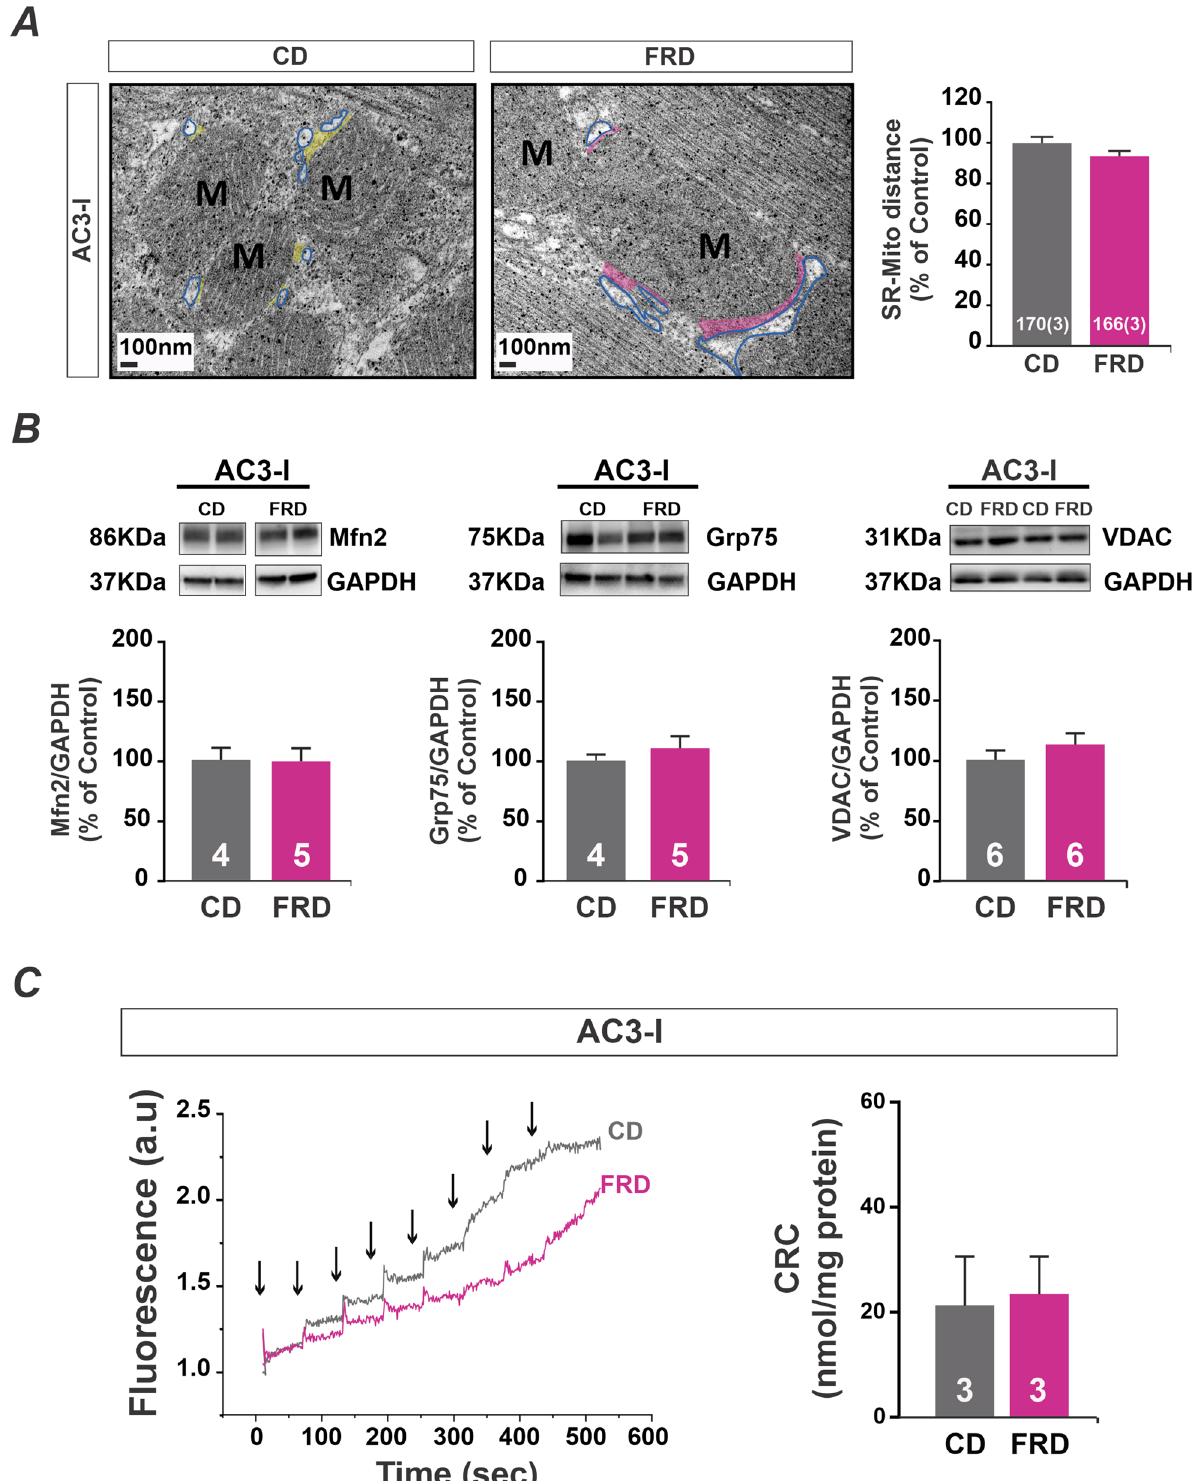
Figure 6. Genetic CaMKII inhibition prevents SR-mitochondria increased proximity avoiding mitochondrial Ca 2+ retention capacity in prediabetic mice heart. ( A ) Left, representative skeletonized photographs of transmission electron microscopy (TEM) showing that AC3-I mice heart samples are protected from decreased SR-mitochondria distance induced by FRD. The SR membrane was skeletonized with a blue line and SR-mitochondria distance was indicated in yellow for CD and pink for FRD AC3-I specimens. On the right, average data of these results. ( B ) Representatives immunoblots and average data of Mfn2, Grp75, and VDAC expression in CD and FRD AC3-I mice heart. Similar results were obtained in FRD and CD AC3-I mice. ( C ) Ca 2+ retention capacity (CRC) representative fluorescence traces from AC3-I mitochondria (CD in gray and FRD in pink) are shown on the left. Arrows indicate Ca 2+ pulses addition to the suspension. On the right, the average data from these experiments shows no differences between CD and FRD AC3-I